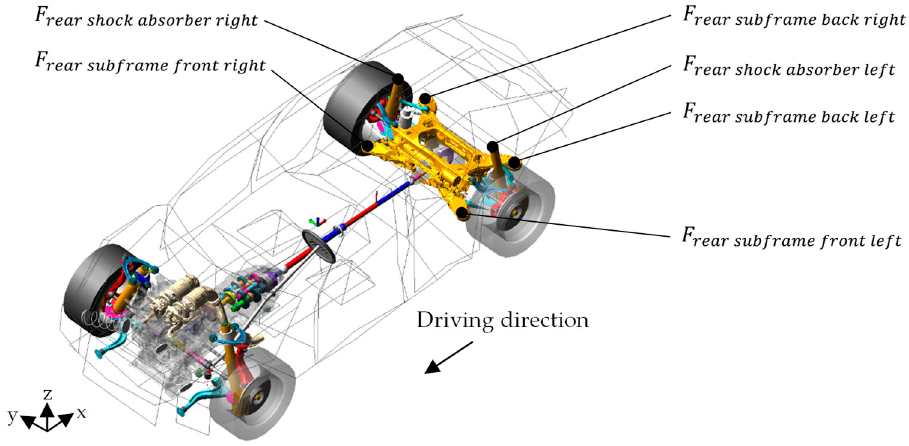
Figure 3. Chassis and powertrain simulation model (MBS).